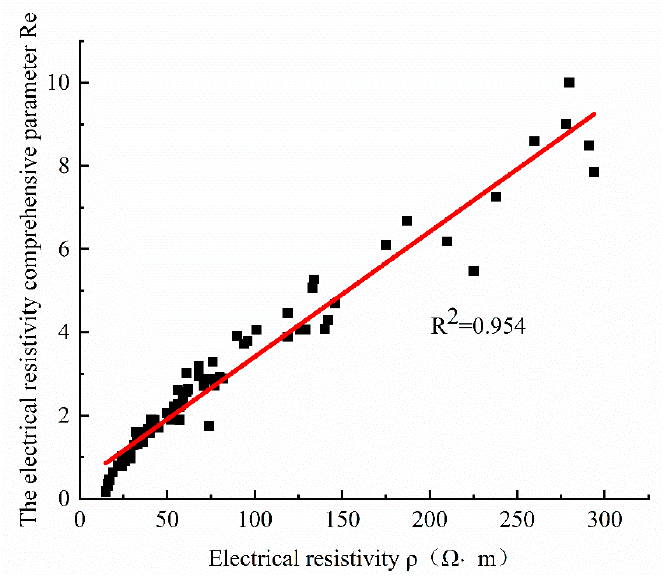
Figure 7. 𝑅 (cid:3032) − 𝜌 Fitting relationship. Figure 7. R e - ρ Fitting